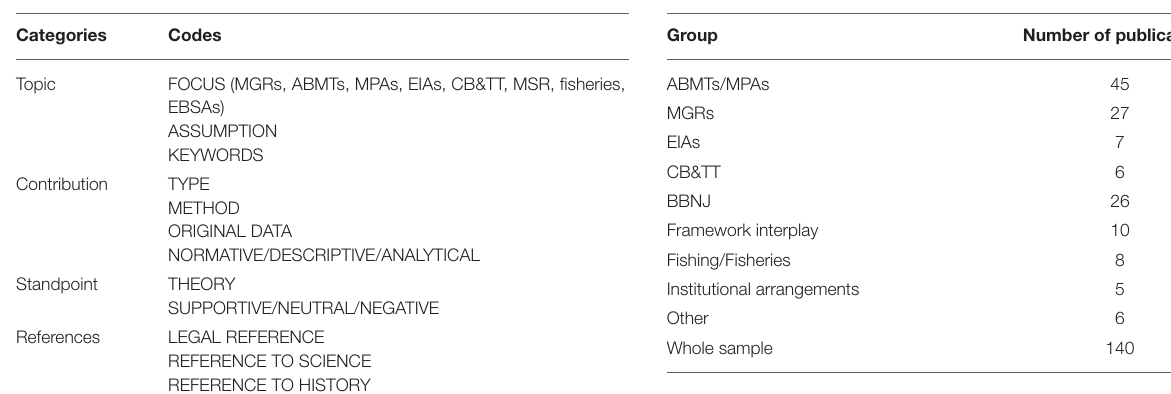
TABLE 1 | Categories and codes for the coding process. TABLE 2 | Overview of number of publications per group in the literature